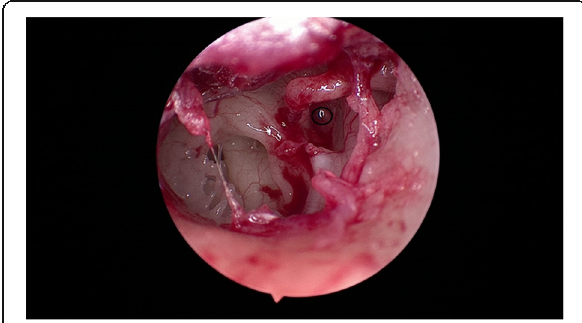
Fig. 3 Stapedotomy (fenestration) being performed at the center of the black circle